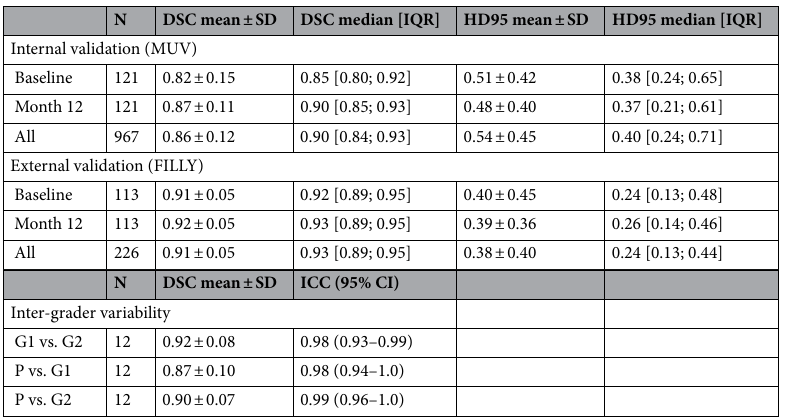
Table 2. Evaluation metrics of the algorithm for internal and external validation and inter-grader variability. DSC Dice Similarity Coefficient, SD standard deviation, IQR interquartile range, HD Hausdorff distance (mm), ICC intraclass correlation coefficient, G1 Grader 1, G2 Grader 2, P